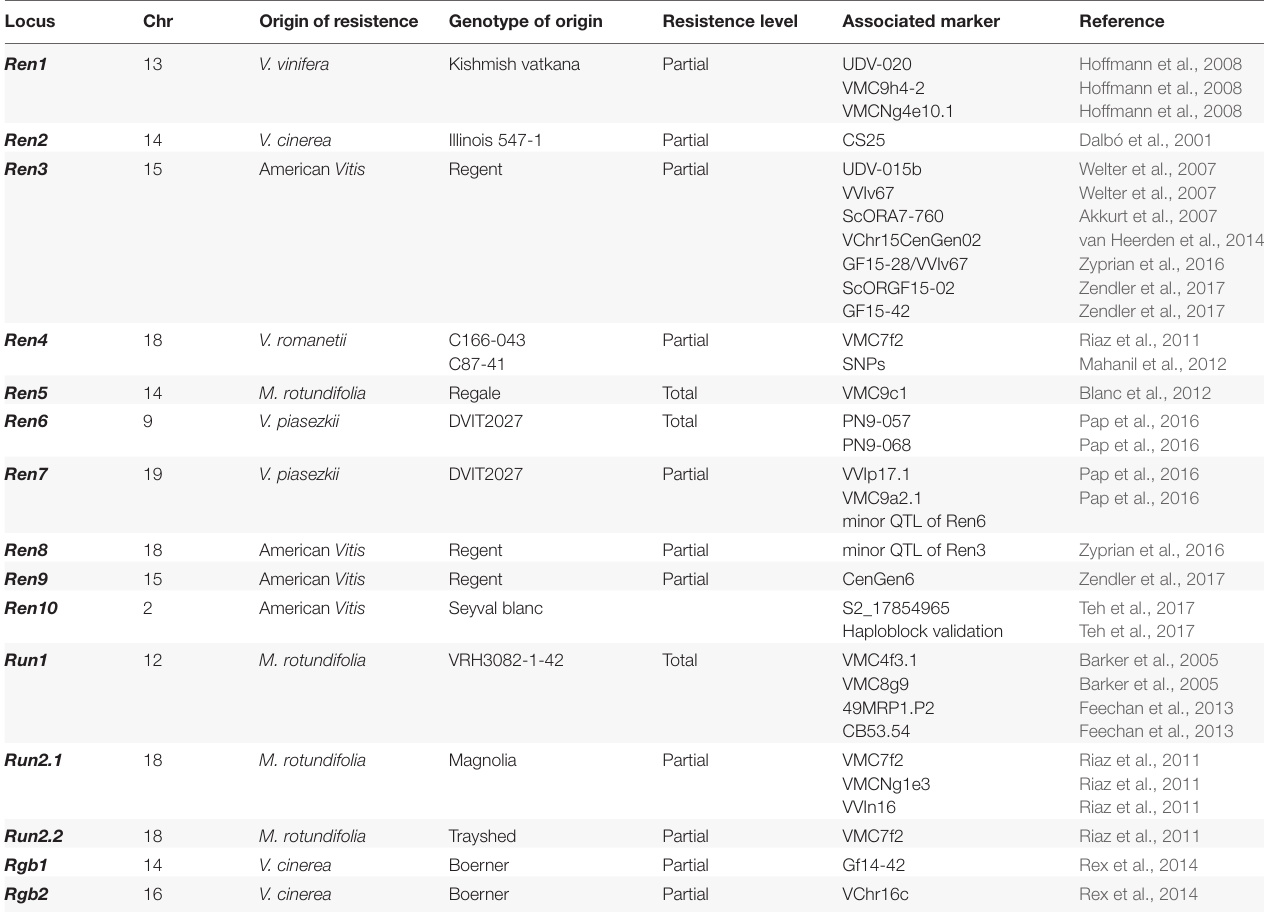
TABLE 1 | R -loci associated with powdery mildew ( Run/Ren ) and black rot ( Rgb ) resistance [improved based on VIVC web source developed by Maul et al. (2012), Merdinoglu et al. (2018), and Hausmann et al. (2019)].